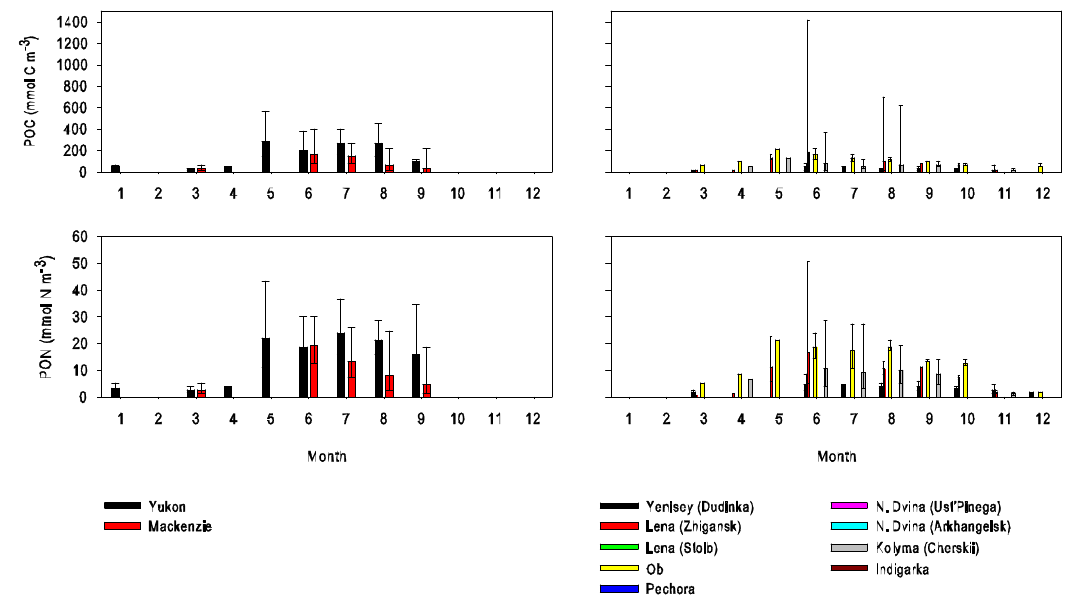
Fig. 2. Monthly-binned concentrations of riverine POC and PON for the North American and Eurasian rivers. Bars with no standard devia- tions indicate single values. Non-filled bars indicate no data